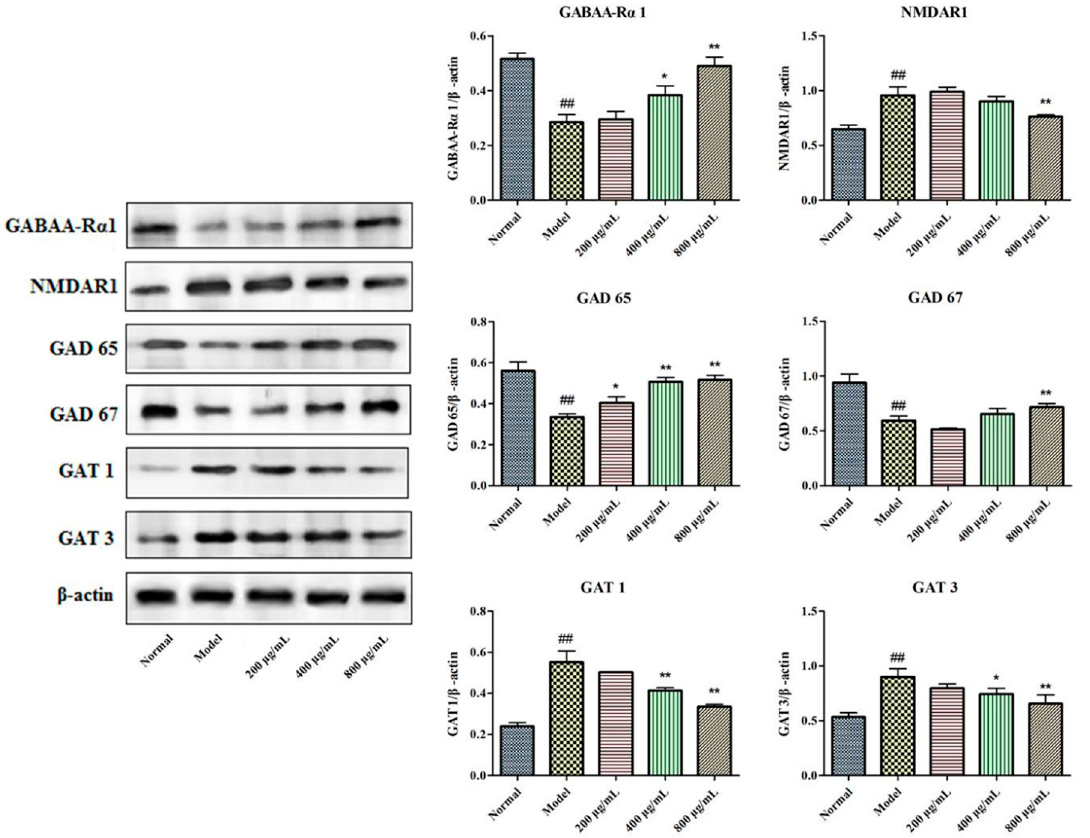
Figure 5. Effects of BBPs on protein expressions of GABAA-R α 1, NMDAR1, GAD65, GAT-1, GAT-3 and GAD67 in NGF-induced PC12 cells injured by Glu. PC12 cells (induced by 50 ng/mL NGF for 48 h) were treated with BBPs at concentrations of 200, 400 and 800 μ g/mL for 24 h, subsequently subjected to Glu at the concentration of 20 mmol/L for a further 24 h. GABAA-R α 1, NMDAR1, GAD65, GAT-1, GAT-3 and GAD67 proteins were detected by Western blotting, whereas β -actin was detected as the control. Normal group: NGF-induced cells without BBPs and Glu; Model group: NGF-induced cells without BBPs, but with 20 mmol/L Glu; BBPs: protein extracts in Bombyx batryticatus. The values represent mean ± SD ( n = 3). ## P < 0.01, vs. normal group; * P < 0.05 and ** P < 0.01, vs. model group.